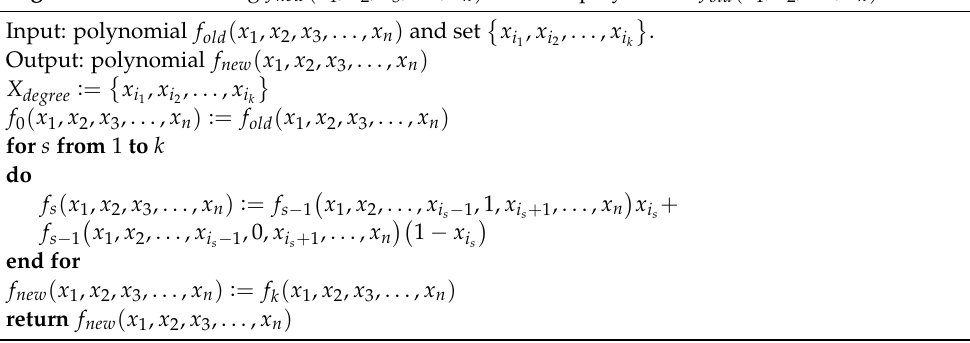
Algorithm A1 : Obtaining f new ( x 1 , x 2 , x 3 , . . . , x n ) from the polynomial f old ( x 1 , x 2 , . . . , x n